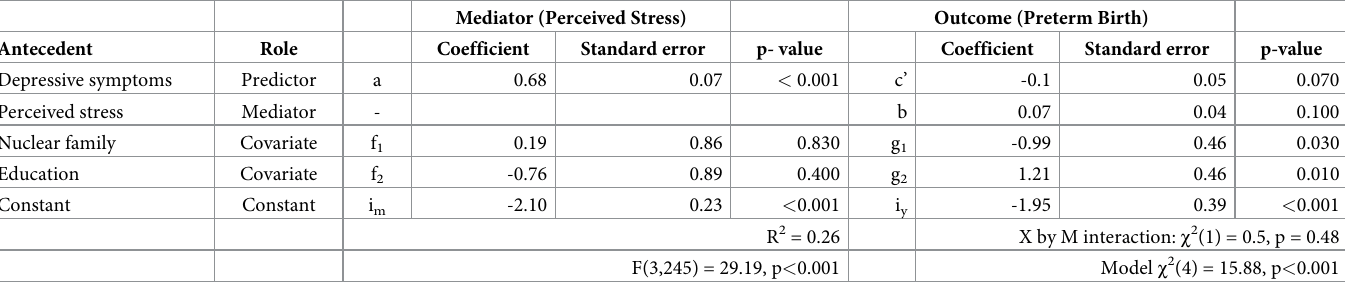
Table 5. Regression analysis examining the mediation of the effect of change in depressive symptoms on preterm birth by change in perceived stress.